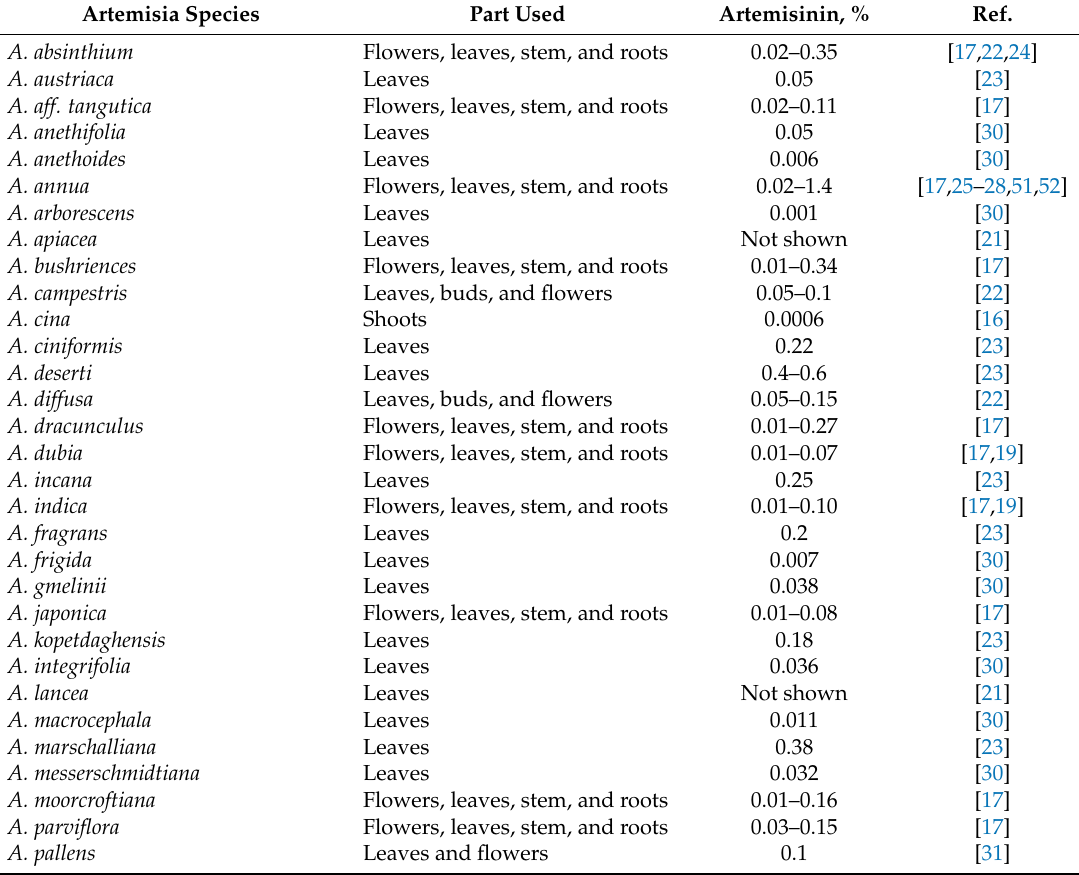
Table 3. Summary of literature reports showing presence of artemisinin in Artemisia